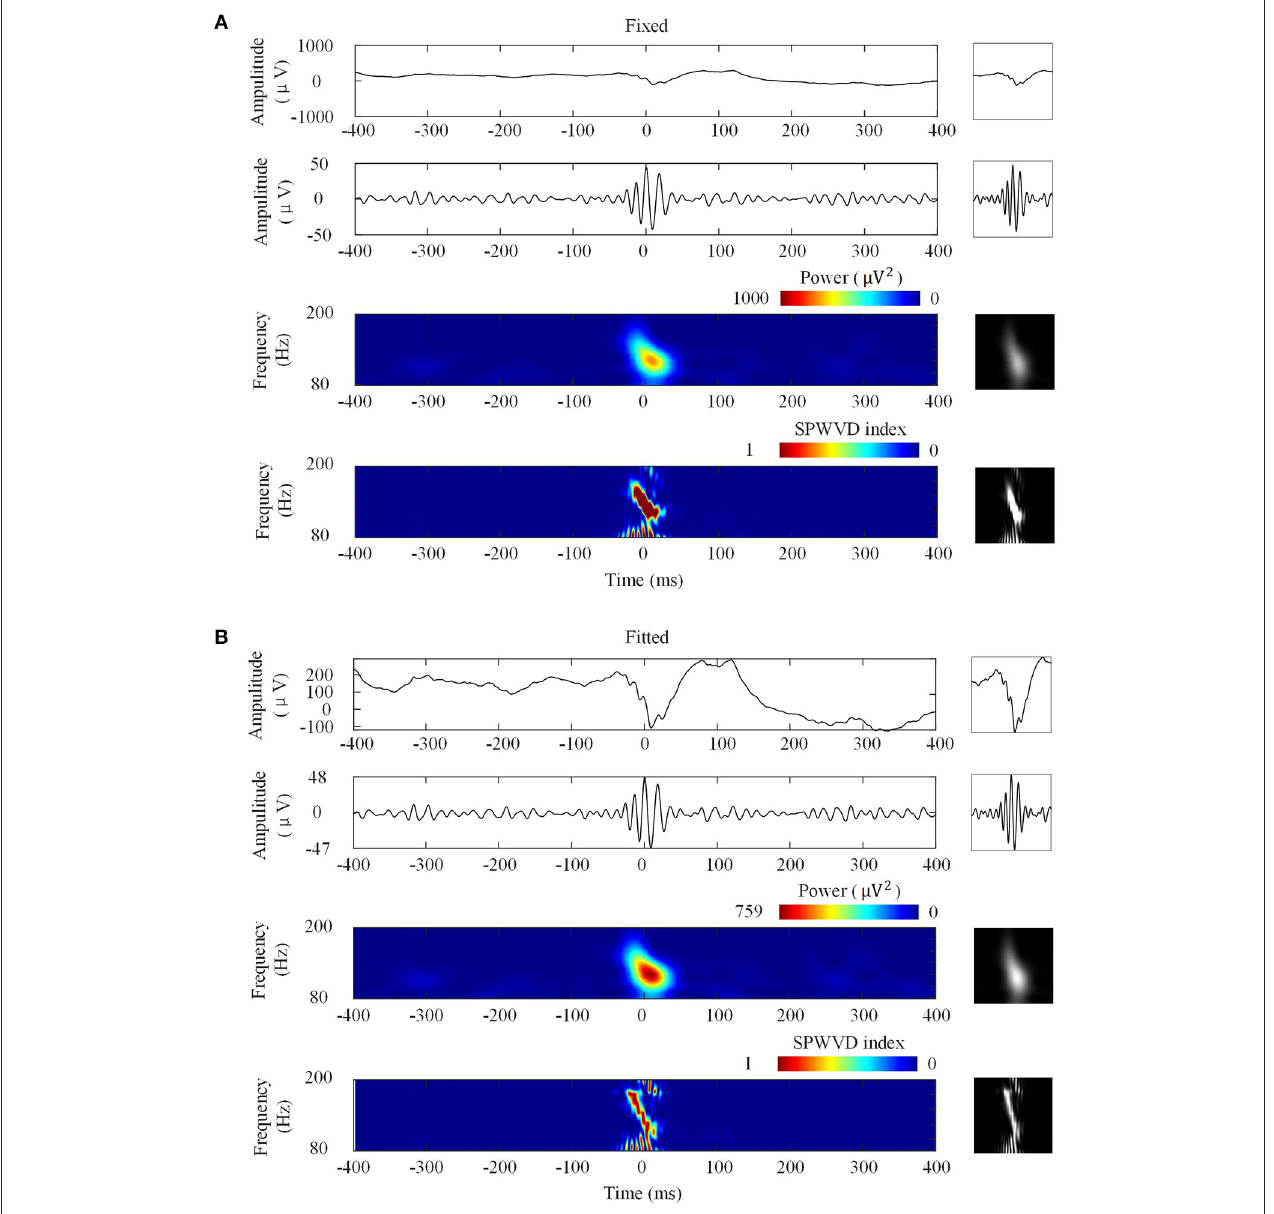
FIGURE 3 | Four ripple image transformations. Left: Transformations of a ripple. Right: Network inputs in the form of two-dimensional 96 × 96-pixel images that represent various transformations. (A) Transformations with fixed scales. From top to bottom are original waveforms, filtered (80–200Hz) waveforms, wavelet spectrum images, and ASPWVD spectrum images. (B) Transformations with fitted scales. From top to bottom are original waveforms, filtered (80–200Hz) waveforms, wavelet spectrum images, and re-normalized SPWVD images.